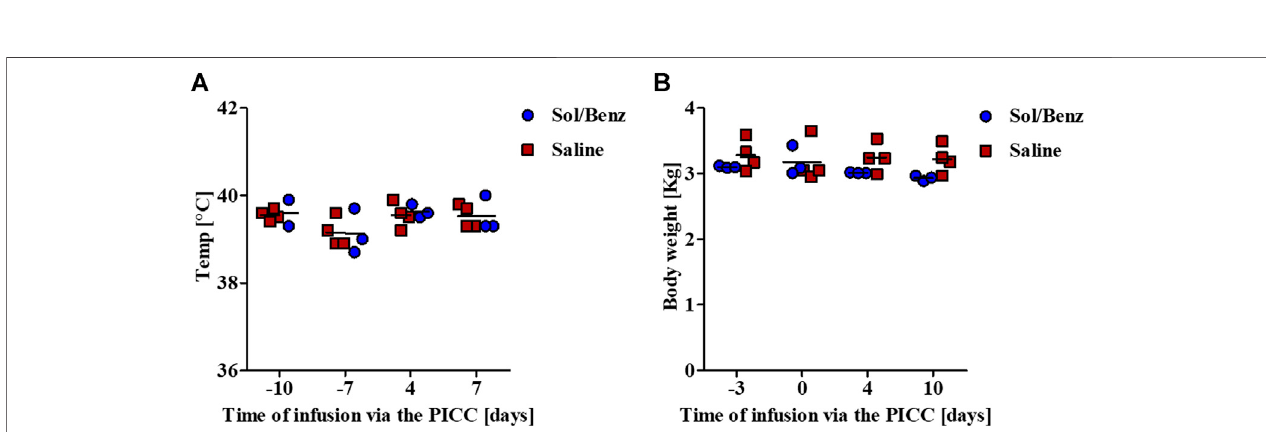
FIGURE 5 | Monitoring vital physiological parameters. Body temperature and weight were measured prior to and during the continuous infusion period (A) Body temperature was measured rectally (B) Rabbits were measured while carrying all the infusion equipment. The net weights were calculated by subtracting the weight of the pumps, including the reservoirs, jackets, and